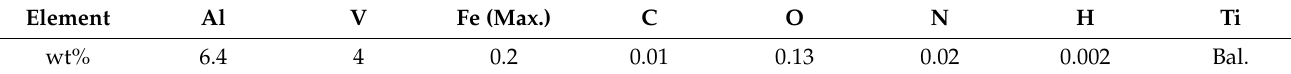
Table 1. The chemical composition of the used Ti-6Al-4V alloy. Element